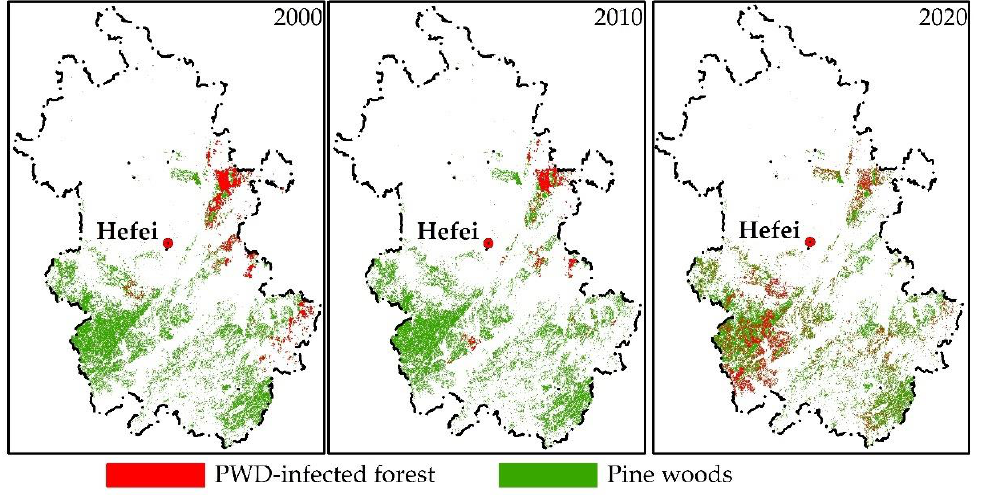
Figure 2. Map of pine forest and PWD.